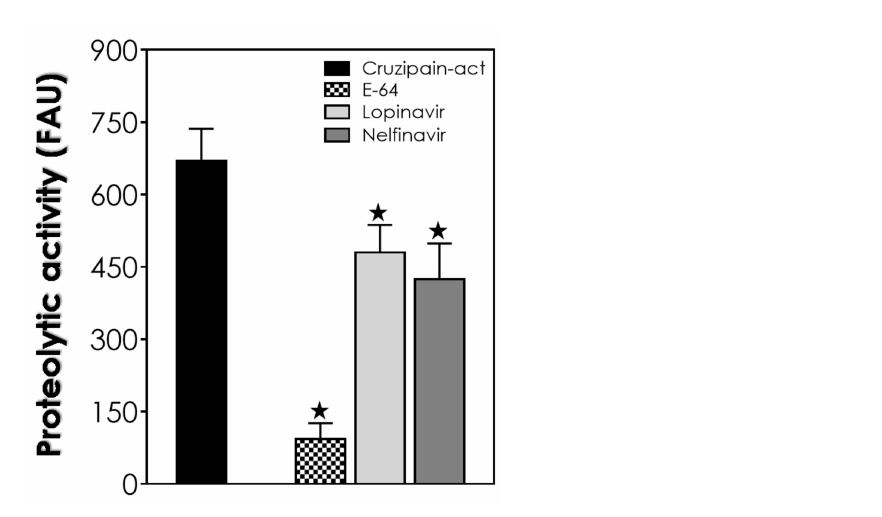
Figure 4. Effects of lopinavir and nelfinavir on cruzipain activity present on the Fraction B2 of the reservosomes of T. cruzi . The cruzipain activity (act) was quantified fluorometrically over a specific substrate used to detect cathepsin-L-like cruzipain activity in the absence ( control: black bars ) or in the presence of 10 µ M of lopinavir, nelfinavir and the classical cysteine peptidase inhibitor E-64. The results are expressed as fluorescence arbitrary units (FAUs), which represent the fluorescence liberated by the fluorophore in 60 min of reaction. Values represent the mean ± standard deviation of three independent experiments. The black stars represent significant statistical differences in systems with pepstatin A compared to the respective controls ( p <